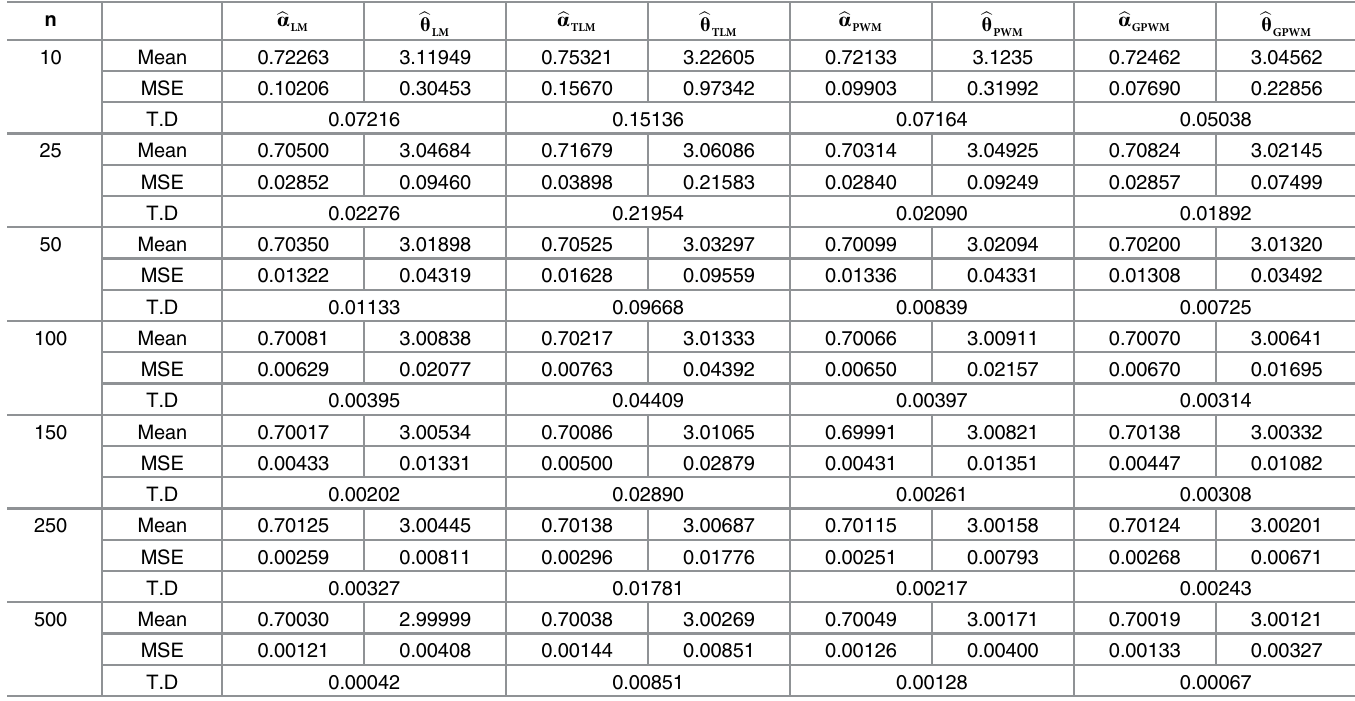
Table 2. Comparison of the estimation methods for ( α = 0.7, θ = 3).